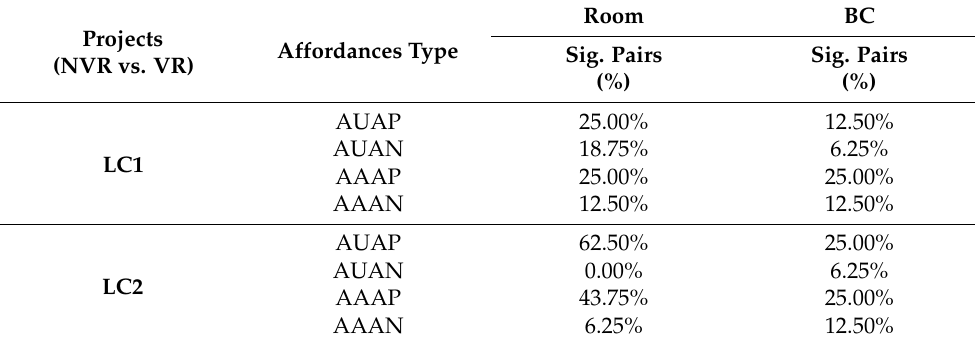
Table 17. Percentages of affordance pairs that have a significant p -value in the LC project. Projects